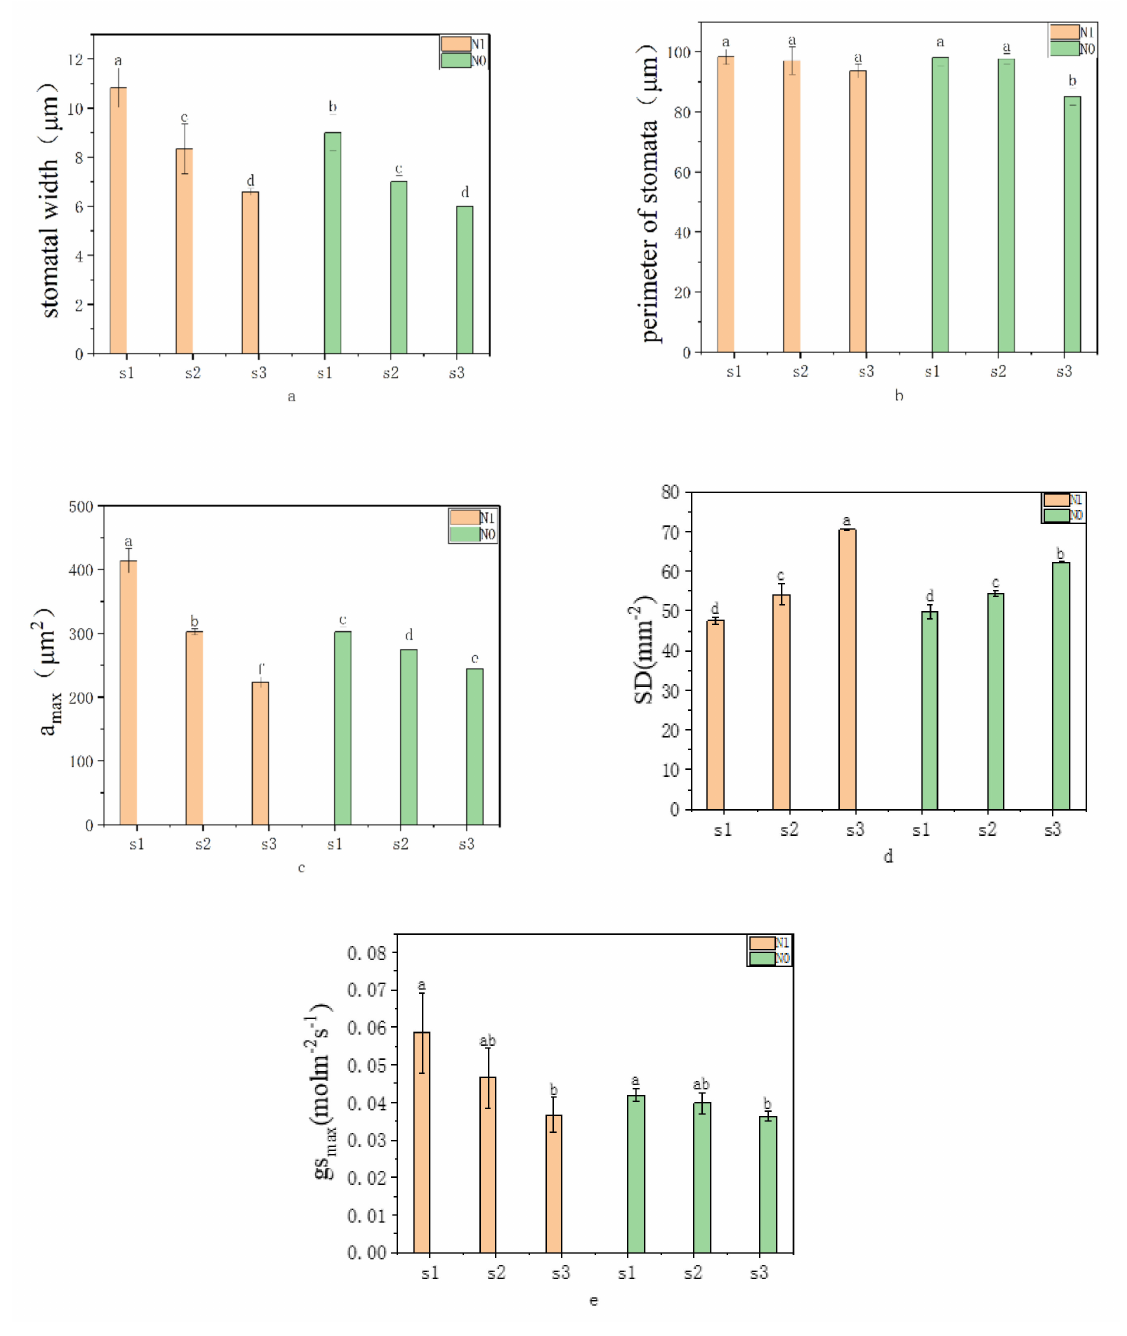
Figure 8. Effects of different nitrogen (N) and salt (S) treatments on stomatal width ( a ), perimeter of stomata ( b ), a max , maximum stomatal area ( c ), SD, stomatal density ( d ), g smax , maximum stomatal conductance ( e ) at the stage of V12. The ANOVE results are given for each S and N. Values are means ± SD per treatment. Different letters indicate statistically significant ( p < 0.05) differences between the treatments using a Tukey post hoc test. N1 is nitrogen application, and N0 is no nitrogen application. S1, S2 and S3 are the soil salinity concentrations of 0%, 0.1% and 0.25%,